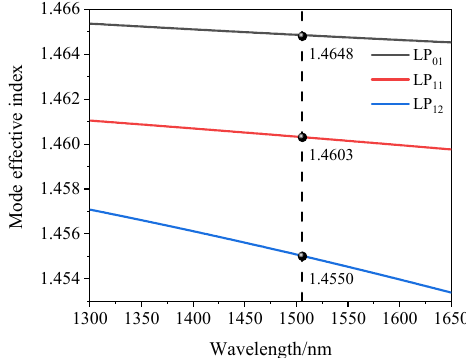
Figure 7. Mode dispersion curve simulated by FEM.